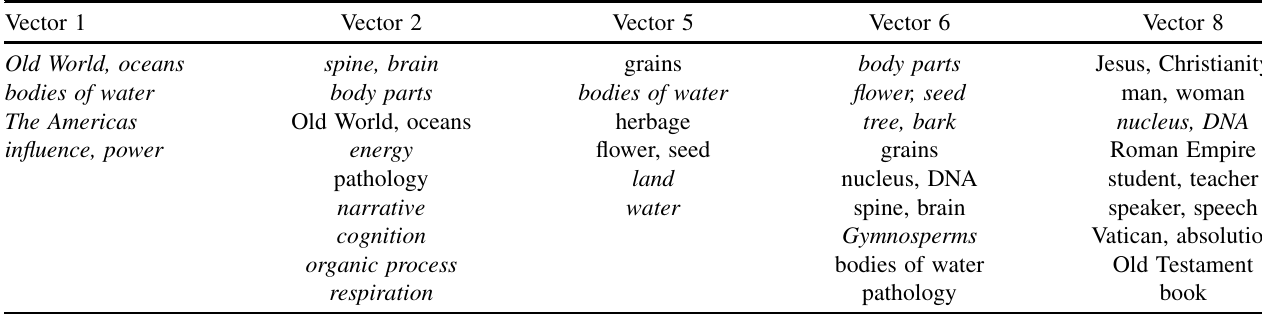
TABLE III. Examples of the highest singular components for the dictionary. The elements in the singular components are the semantically cohesive clusters of words obtained from decomposing the core. For table entries, word(s) representing the main theme of each cluster are chosen. Clusters are listed in order of the absolute value of their coefficient in the singular component. Only clusters whose coefficients have absolute values that are greater than 0.1 have been listed. Plain text and italics indicate the clusters that have coefficients with positive and negative values, respectively. The third, fourth, and seventh highest singular components are very similar to vectors already shown and are therefore not